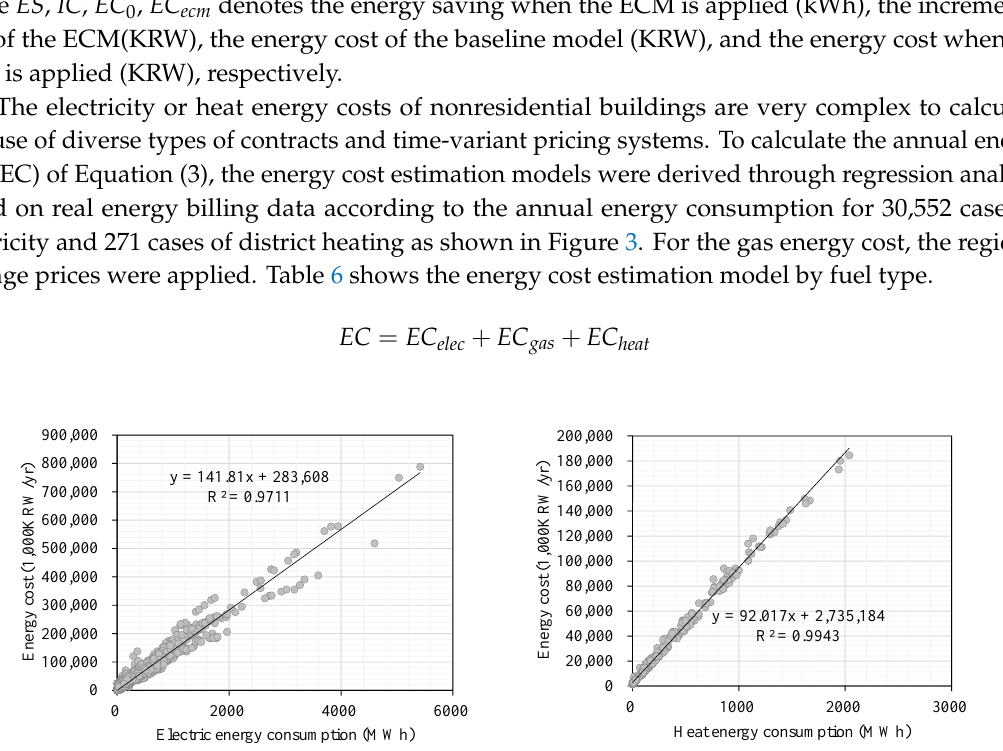
Figure 3. Energy cost model based on billing data for electricity and heat energy consumption. Table 6. The summary of energy cost estimation model by fuel type.